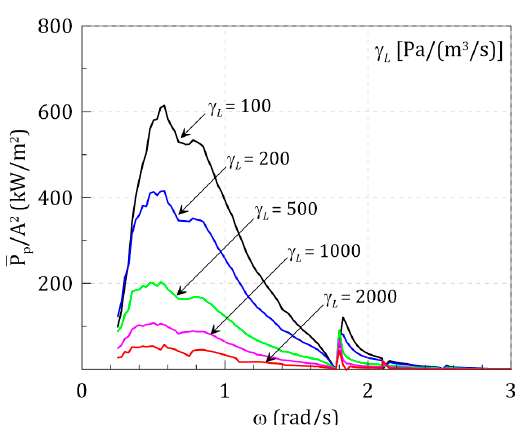
Figure 11. Transfer function of pneumatic power converted by the OWC chamber under various wave frequencies and linear pressure drop coefficients.